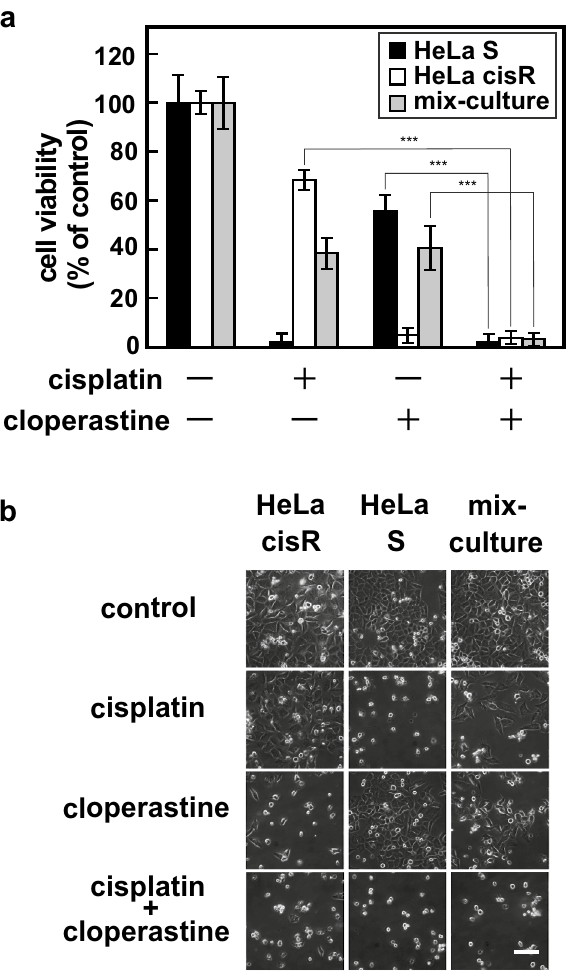
Figure 3. Combined use of cloperastine and cisplatin effectively kill both cisplatin-resistant and cisplatin- sensitive cancer cells in a mixed population. ( a ) Cytotoxicities of cloperastine and/or cisplatin toward HeLa S cells and HeLa cisR cells were analyzed separately or together as a mixed population. For the separate cultures, 4 × 10 3 HeLa S cells/well, or 1.5 × 10 4 HeLa cisR cells/well were analyzed. For the mixed population (combined culture), HeLa S cells (2 × 10 3 cells/well) and HeLa cisR cells (7.5 × 10 3 cells/well) were mixed and seeded into each well of a 96-well plate. After incubation for 1 day to allow the cells to attach, 100 µM cloperastine and/ or 10 µg/ml (33 µM) cisplatin were added, and the cells were incubated for an additional 3 days, after which cell viability was measured. The results are presented as means ± S.D. of sextuplicate samples. Four separate experiments yielded essentially the same results. The significance of the difference between the selected pairs of results was determined with ANOVA (***p < 0.001). ( b ) Cells treated as in ( a ) were photographed under a phase contrast microscope. Bar, 100